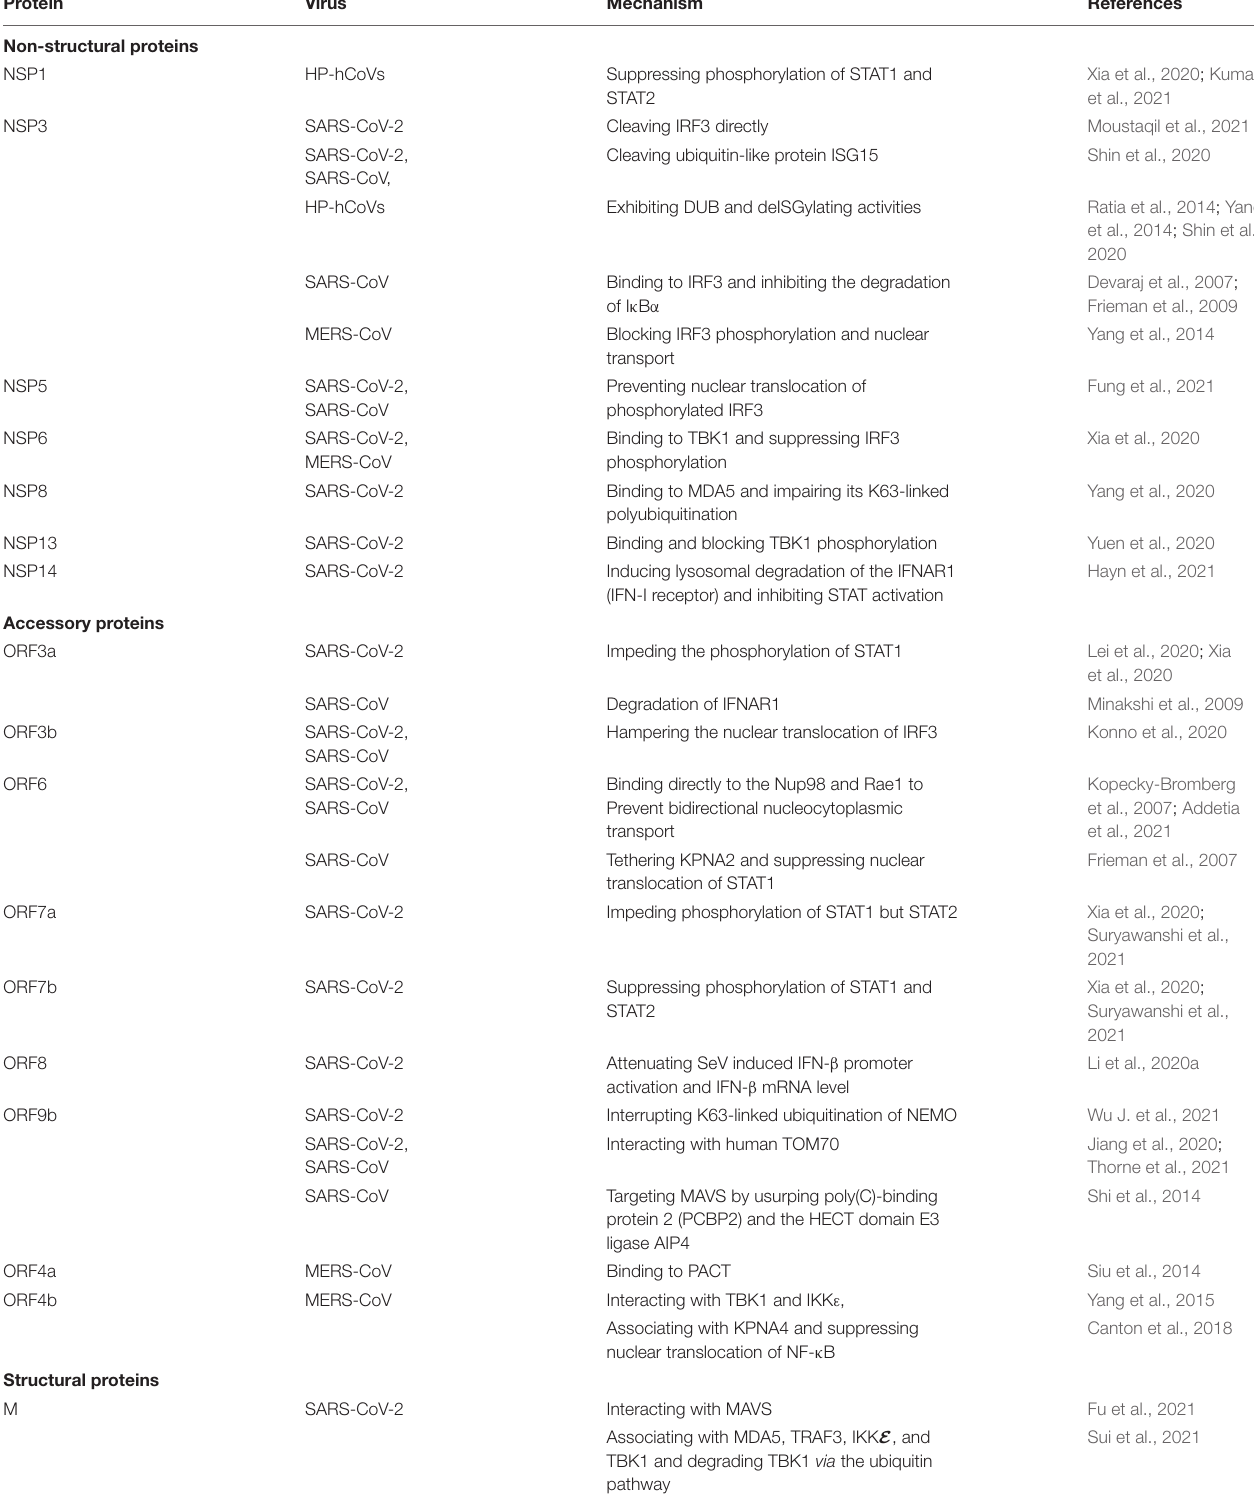
TABLE 2 | Evasion IFN-I system by HP-hCoV-encoded